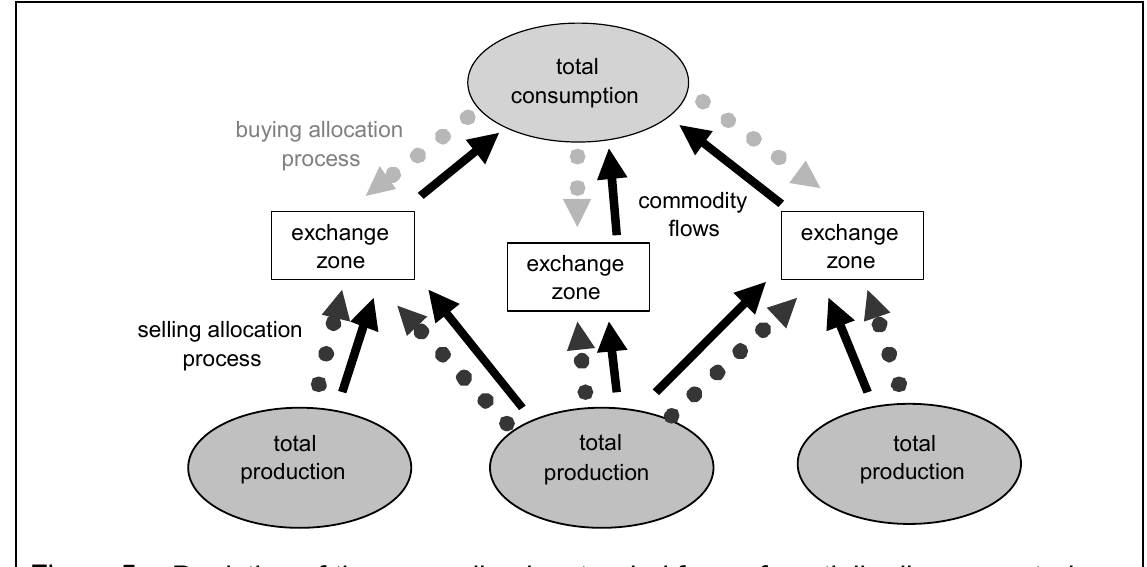
Figure 5: Depiction of the generalized, extended form of spatially-disaggregated input-output approach used in the production and allocations and interactions